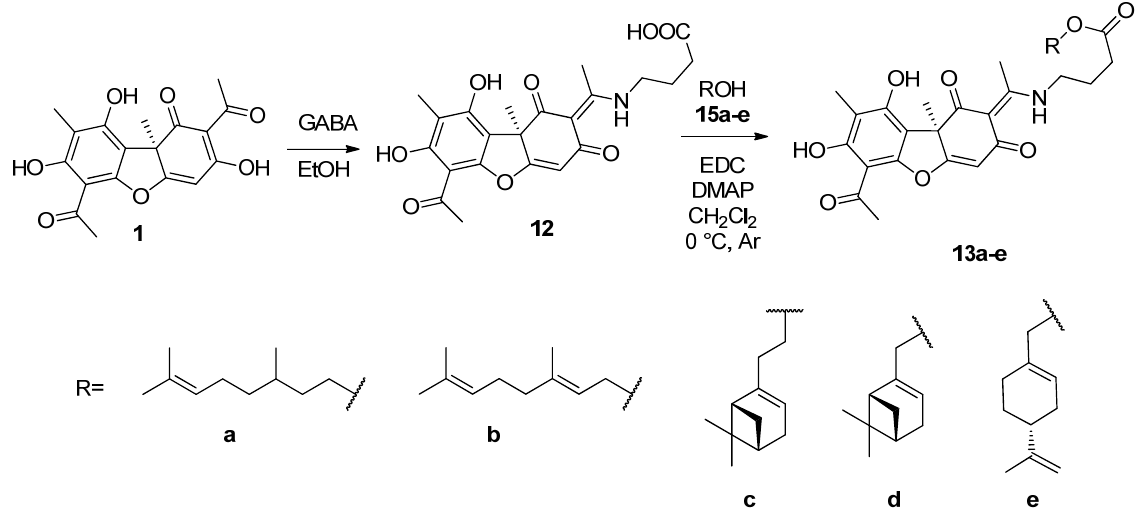
Table 5. The influence of UA derivatives 11a–e and 13a–e on TDP1